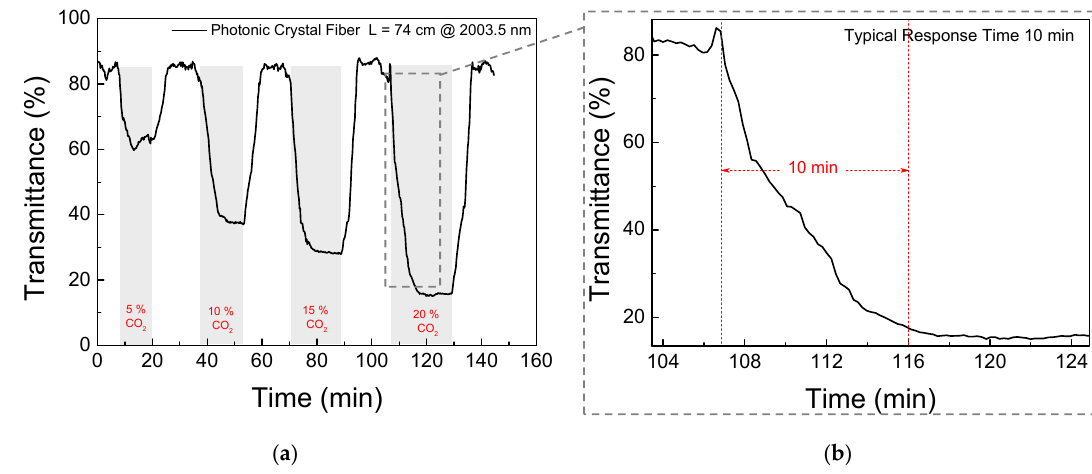
Figure 7. ( a ) Transmittance measured for cycles of different CO 2 concentration (0%, 5%, 10%, 15%, and 20%); ( b ) the response time of the system.